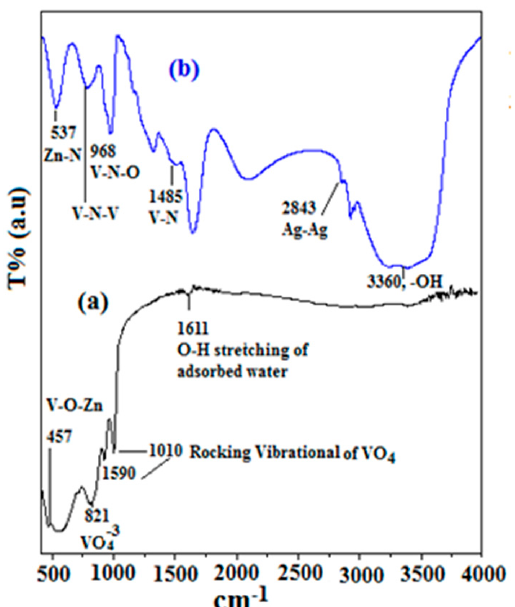
metal nitrides. Figure 1. IR spectra of ( a ) [Ag 0.05 ZnO 0.05 V 2 O 5(0.90) ]; and ( b ) [Ag 0.05 ZnO 0.05 V 2 O 5(0.90) ] N . The XRD patterns of [Ag 0.05 ZnO 0 . 05 V 2 O 5(0.90) ] and [Ag 0.05 ZnO 0.05 V 2 O 5(0.90) ] N have been interpreted using JCPDS No. 89-2483, ICDD PDF No. 35-768, and ICSD No. 98-018-0878, Figure 2. The XRD profile of [Ag 0.05 ZnO 0.05 V 2 O 5(0.90) ] illustrates nanocrystals of V 2 O 5 and